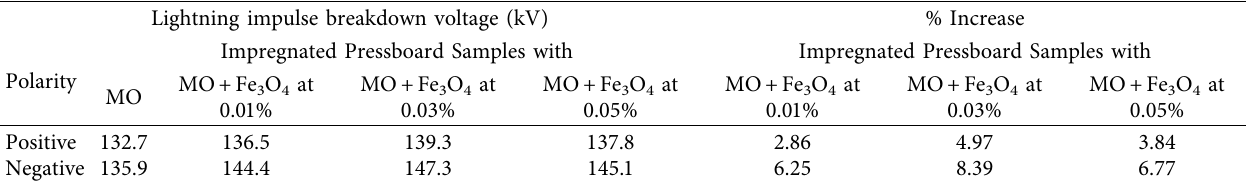
Table 6: Results of the lightning impulse breakdown voltage of the impregnated pressboard. Lightning impulse breakdown voltage (kV) % Increase Impregnated Pressboard Samples with Impregnated Pressboard Samples Polarity